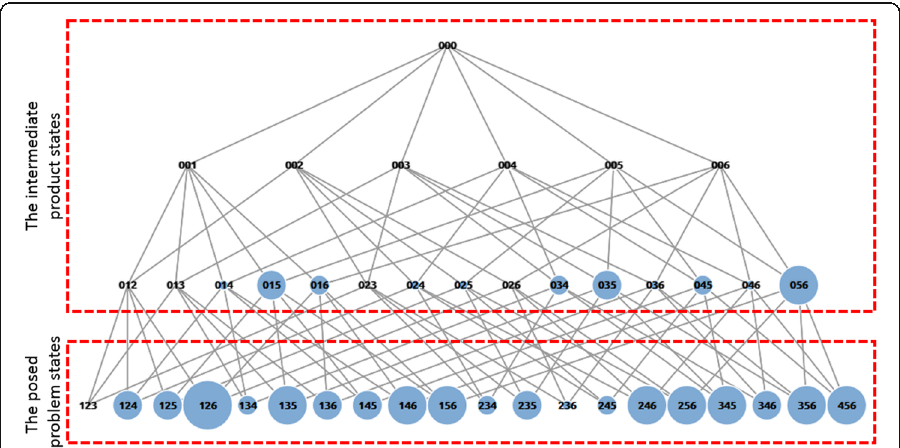
Fig. 6 Graph of the number of violated constraints of products in assignment